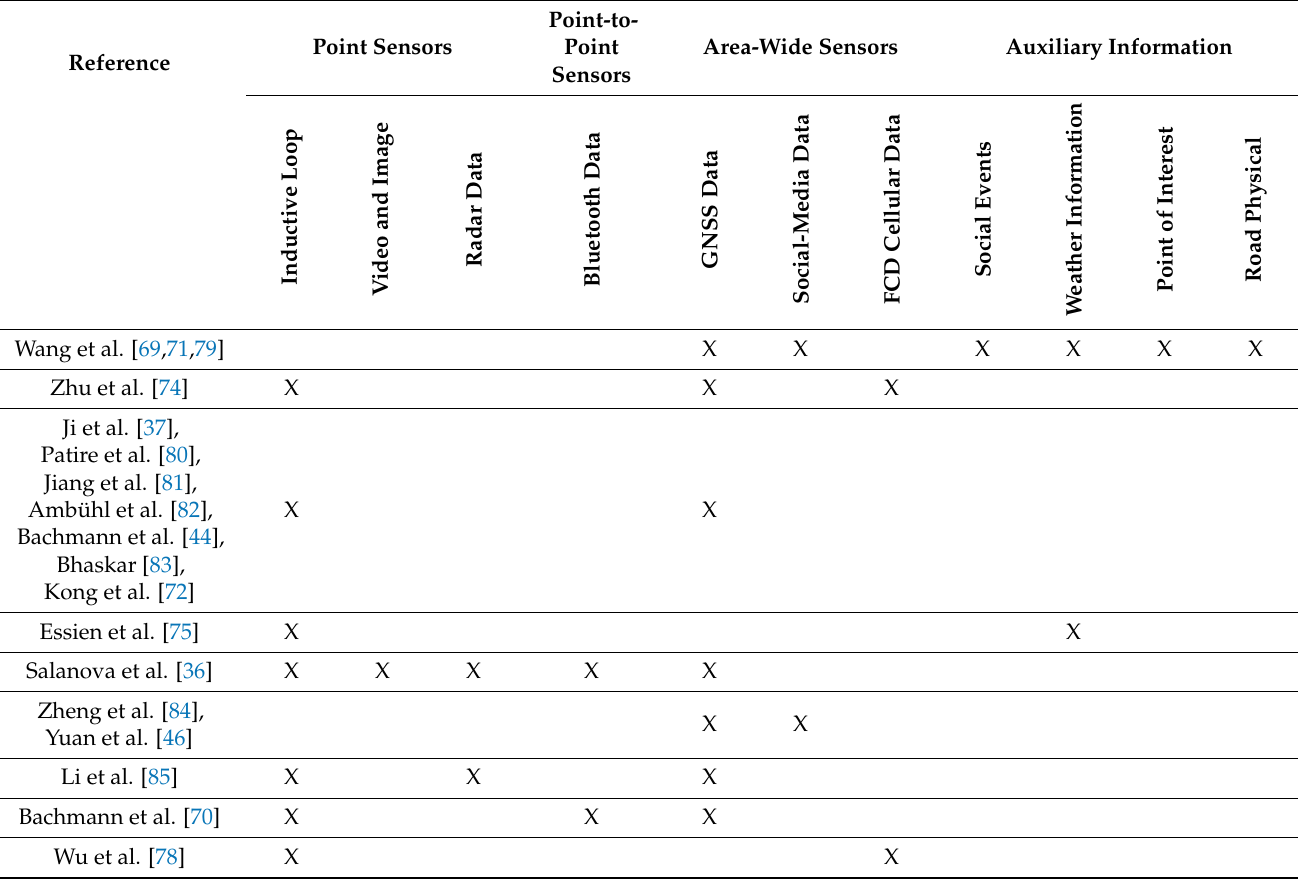
Table 4. Multisource Data Used for Fusion and Congestion